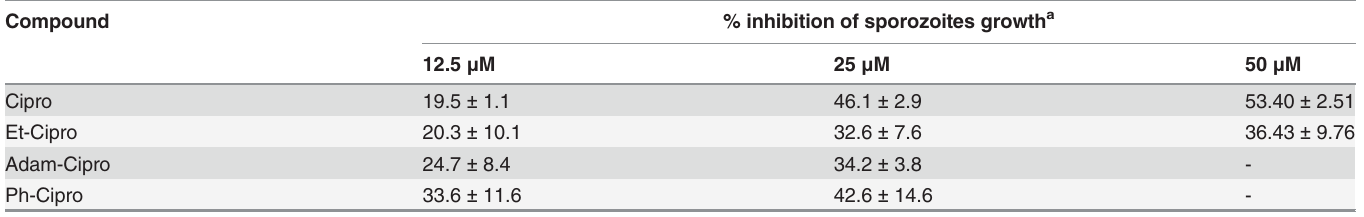
Table 2. Effect of treatment with Cipro, Et-Cipro, Adam-Cipro and Ph-Cipro on the growth of Cryptosporidium parvum sporozoites in host cells.